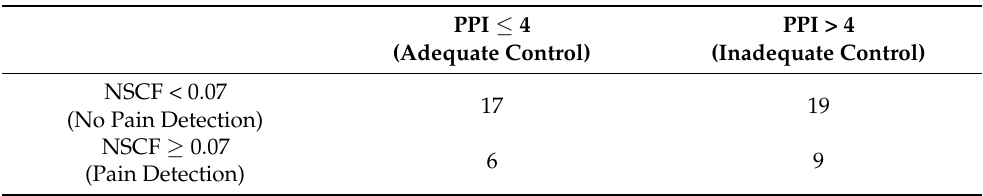
Table 4. Proportion of patients with adequate or inadequate pain control according to changes in the pupillary pain index (PPI) or to the number of skin conductance fluctuations per second (NSCF). Total of patients = 51.